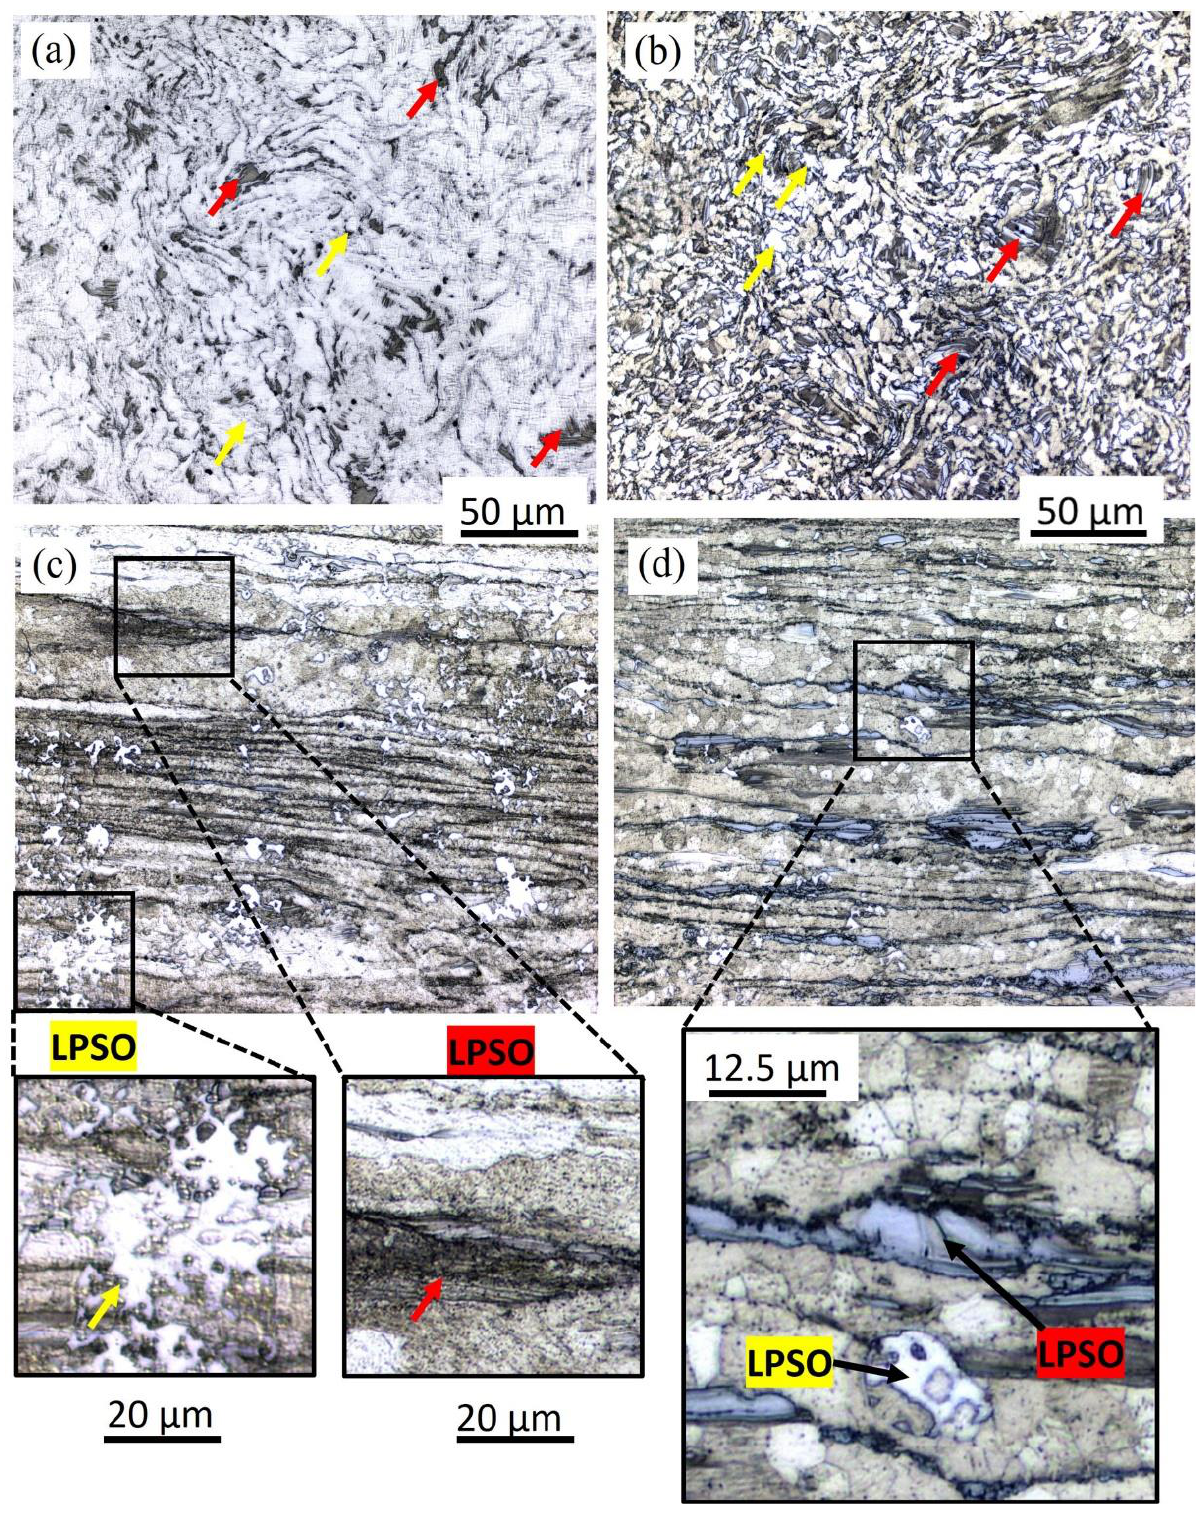
Figure 1. Optical microstructures of the investigated alloys: ( a ) WZ42 — surface parallel to the extrusion direction, ( b ) WZ104 — surface parallel to the extrusion direction, ( c ) WZ42 — surface perpendicular to the extrusion direction, ( d ) WZ104 — surface perpendicular to the extrusion direction. LPSO phases with a lamellar structure consisting of thin platelets are marked by the red arrows LPSO phases with block-like structures are marked by the yellow arrows.